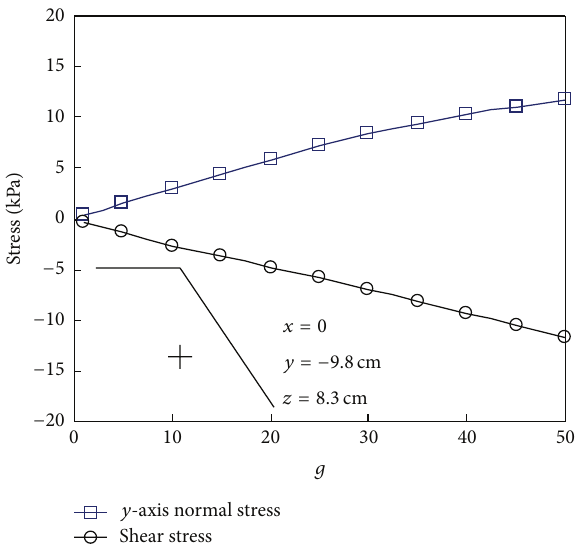
Figure 9: Stress history of a typical point by numerical analysis. g : g-level.